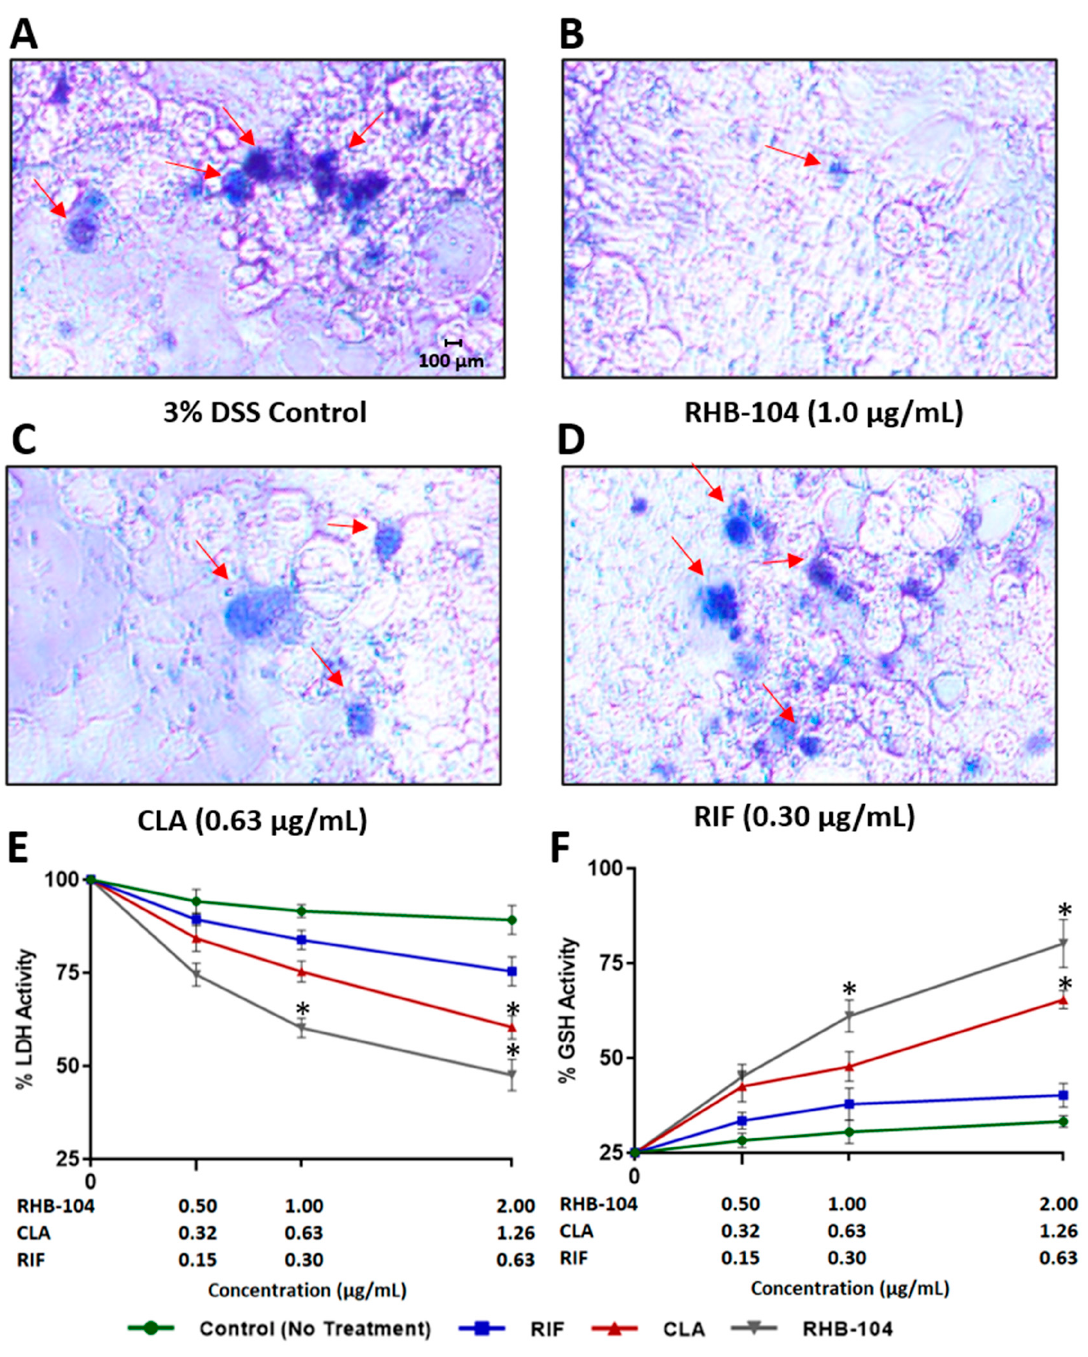
Figure 7. Anti-cytotoxic activity of RHB-104 and its major components in Caco-2 monolayer treated with 3% DSS. Trypan blue exclusion assay showing the cytotoxic effects (indicated by red arrows) in DSS-treated Caco-2 monolayers ( A ), and DSS-treated Caco-2 monolayers with 1.0 µ g / mL RHB-104 ( B ), 0.63 µ g / mL CLA ( C ), and 0.30 µ g / mL RIF ( D ). LDH Activity ( E ) and GSH activity ( F ) in DSS-treated Caco-2 monolayers treated with RHB-104 (0, 0.5, 1.0, 2.0 µ g / mL), CLA (0, 0.32, 0.63, and 1.26 µ g / mL), and RIF (0, 0.15, 0.30, 0.60 µ g / mL) for 24 h. * p < 0.05.